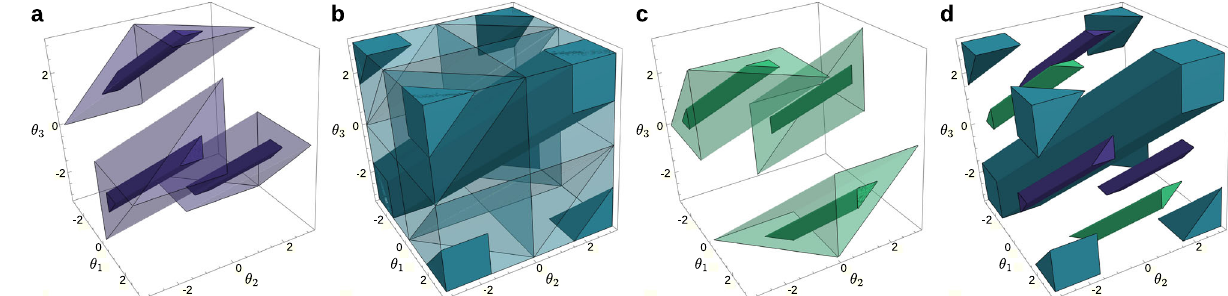
Fig.2|Windingcellsandcohesivesetsinathree-nodesystem. Windingcellsand theircohesivesubsets,foracycleoflength n =3.Thethree-dimensionalplotsshow the unfolded 3-torus, where each dimension parametrizes one of the three angles and the winding cells become polytopes. The sides of the cube have then to be considered as identi fi ed (left-right, top-bottom, front-back). a The transparent volume is Ω (+1; σ ),thewindingcellofwinding number q =+1,and thesolidvolume is the 3 π /4-cohesive set, i.e., the subset of Ω (+1; σ ) where the counterclockwise